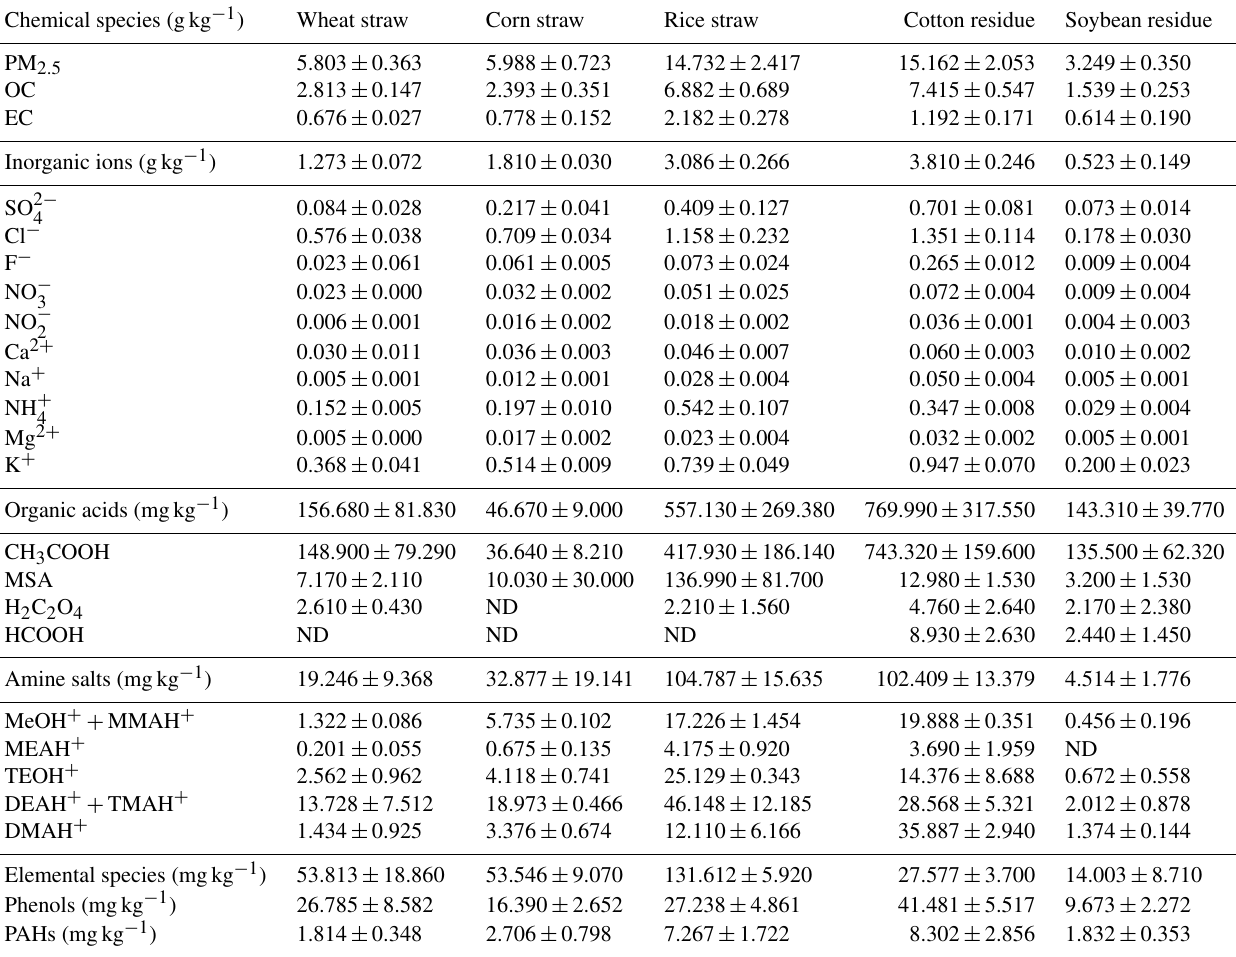
Table 1. Emission factors of particulate chemical species in smoke PM 2 . 5 from agricultural residue burning (mean value ±